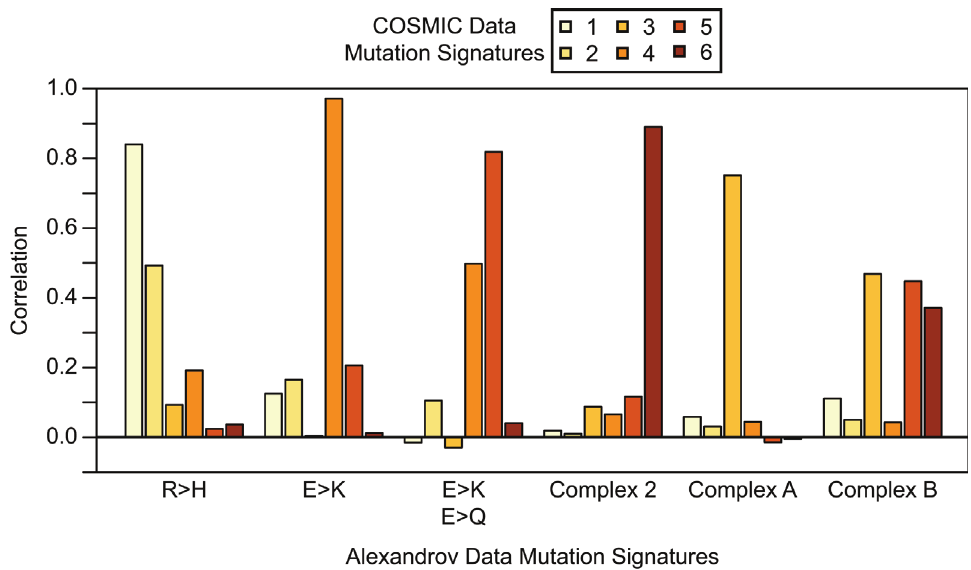
Fig 4. Correlations of COSMIC and Alexandrov mutation signatures. For each COSMIC mutation signature we calculatedthe correlation with each Alexandrovmutation signature. Five of six Alexandrov mutation signaturesreplicatein the COSMIC data for k = 6 mutation signatures.AlexandrovSignatureR > H is replicated by COSMIC Signature1, althougha subset of mutation types that clusteredin the originalR > H are identifiedin the larger COSMIC data set as Signature2. Alexandrov SignatureE > K is replicatedby COSMIC Signature4. AlexandrovSignature E > K, E > Q is replicatedby COSMIC Signature5, althoughit is also correlatedwith COSMIC Signature4 as each of these signaturesshare mutations. Alexandrov SignatureComplex 2 is replicatedby COSMIC Signature6. Alexandrov SignatureComplex A is replicated by COSMIC Signature3. AlexandrovSignature Complex B is not faithfully replicatedby any single COSMIC Signature,as the signal appearsto be spreadamongst COSMIC Signatures3, 5 and 6.